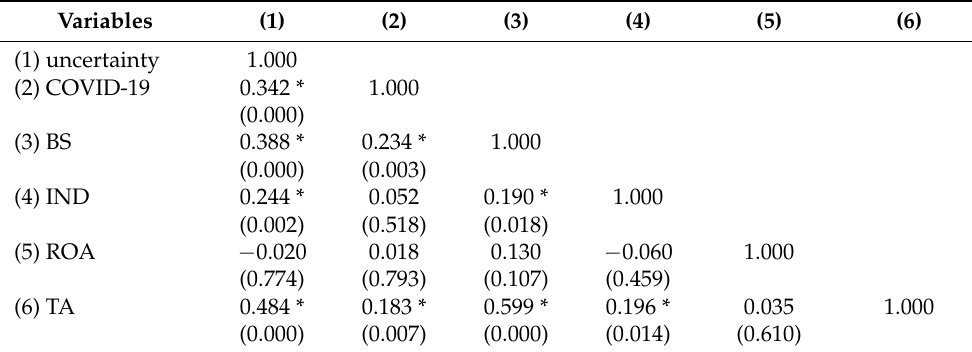
Table 3. Correlations